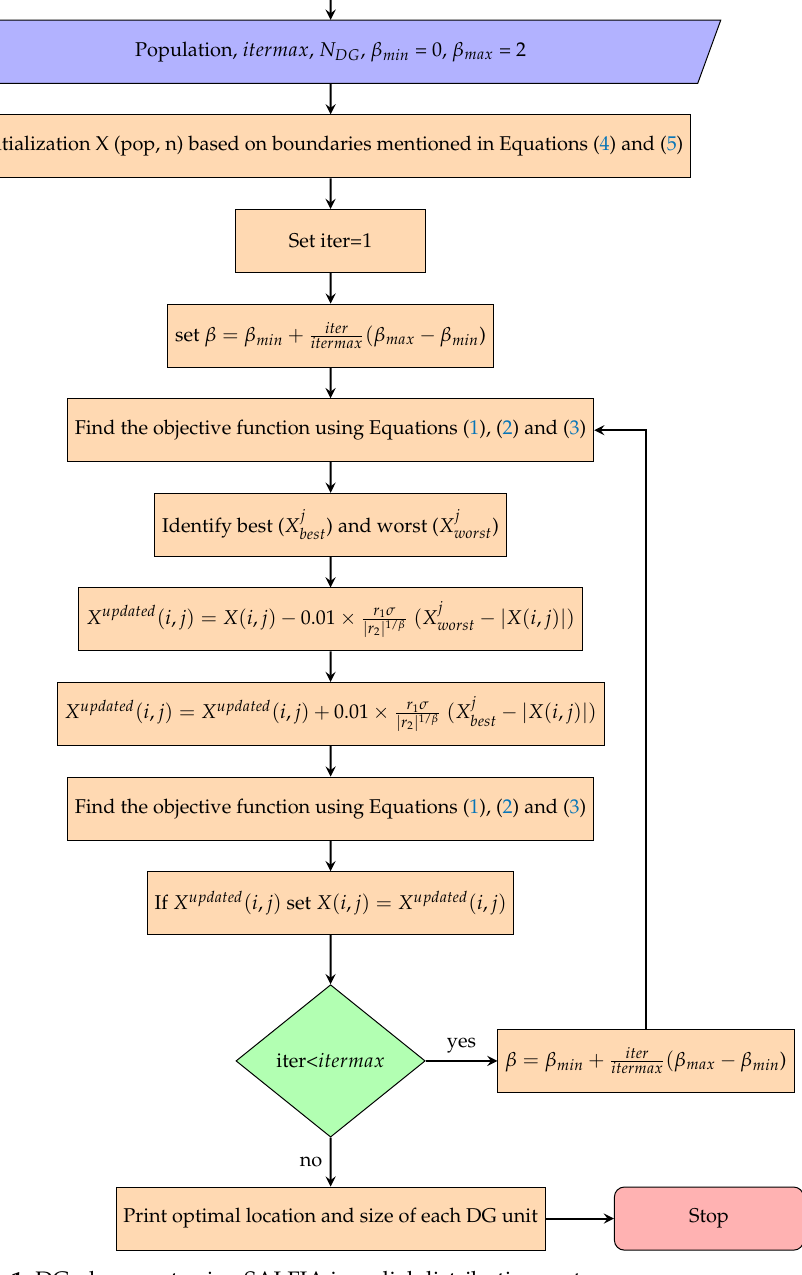
Figure 1. DG placement using SALFJA in radial distribution